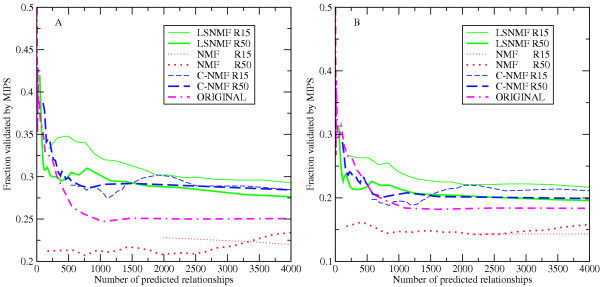
Comparisons of Metagenes and MIPS Functional Classes. Evaluation of metagenes for LS-NMF, NMF, and NMF on scaled data, as well as expression profiles for unreduced data, was done by determining the ability of each approach to find functionally related genes based on the MIPS functional classification. In a, the fraction of correct classifications at level 2 in the MIPS ontology are shown in terms of increasing numbers of gene pairs (i.e., decreasing threshold for correlation). In b, the same information is shown for level 3 in the MIPS ontology. The performance of NMF can be improved by utilizing a divergence based update rule, however performance is still significantly below LS-NMF, with recovery ranging from 12 to 30 times greater with LS-NMF.